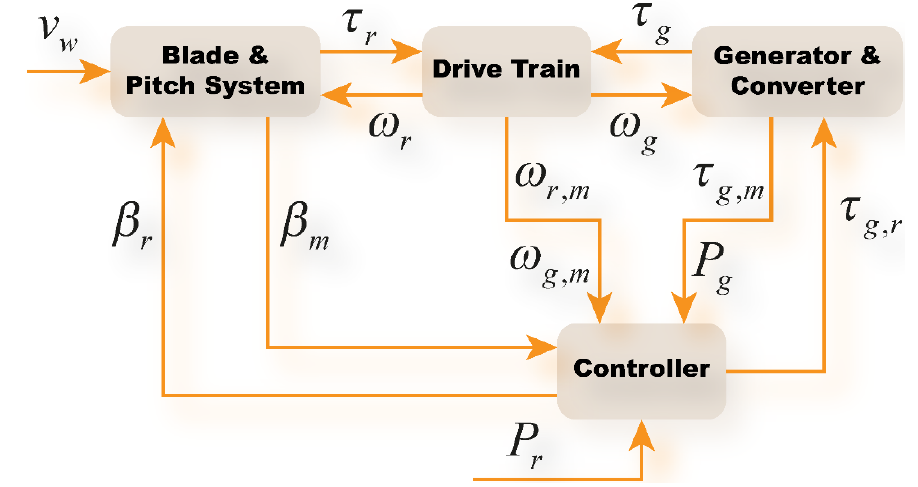
Figure 2. Block diagram of the 4.8 MW benchmark wind turbine model.